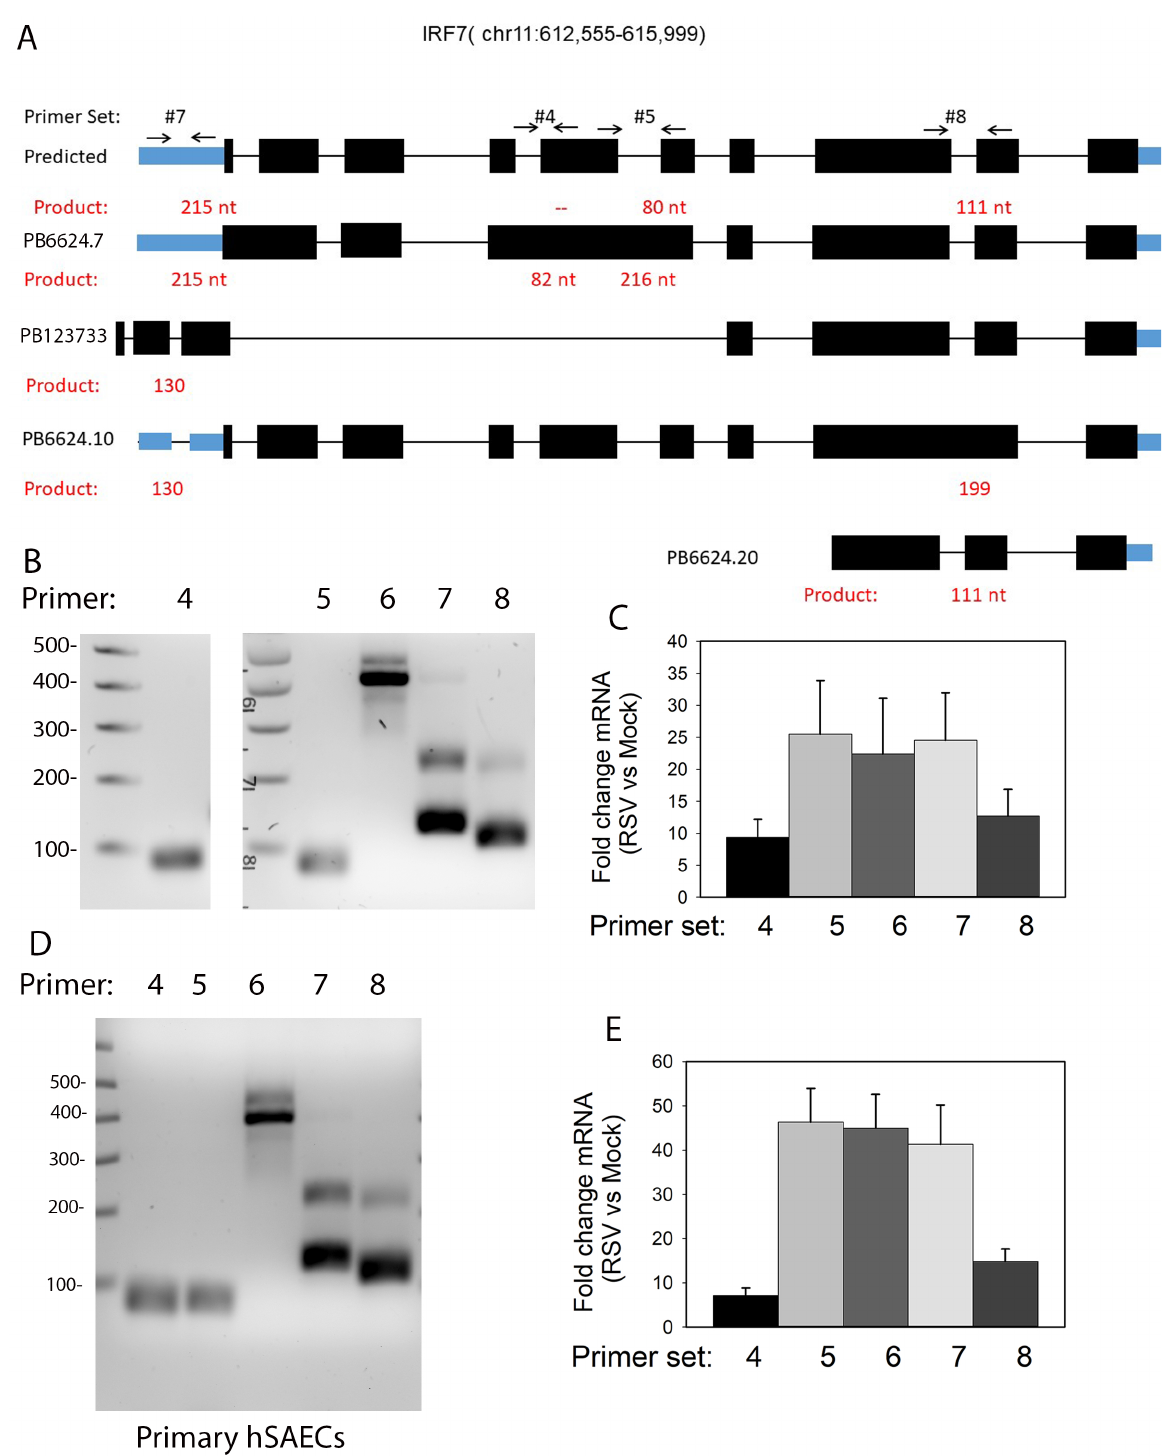
Figure 11. Validation of IRF7 alternative mRNA processing. ( A ) Predicted exons of IRF7. Annotated exons are numbered. For each AS event, primer sets #4-#8 were designed to validate differential exon inclusion/exclusion. The expected size of the PCR product is indicated in red ( B ) Quantitative PCR for each primer set. Shown is agarose gel electrophoresis, with MW (in nt) indicated at the left ( C ) Quantitation of IRF7 transcripts from qRT-PCR. ( D ) Validation of AS in primary hSAECs. Agarose gel electrophoresis as in panel ( C ). ( E ) Quantitation of IRF7 transcripts from qRT-PCR findings indicate that RSV-induced mRNA processing of the IIR is a general response of the small-airway